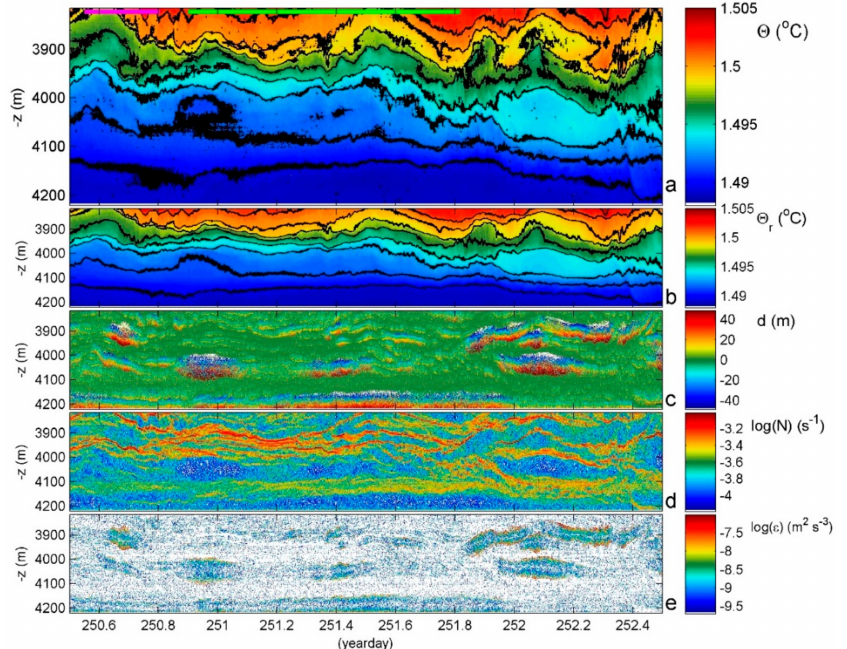
Figure 4. Two day—400 m time-depth T-sensor series example for a near-equatorial South-Pacific DRISCOL area (the local water depth is at the level of the horizontal axis). ( a ) Observed conservative temperature with missing sensors interpolated (see text) and black contours every 2 mK. The green and purple horizontal bars indicate the maximum and mean buoyancy periods, respectively. ( b ) Data from ( a ) reordered to stable profiles. ( c ) Displacements between data from ( a , b ). ( d ) Buoyancy frequency computed from data in ( b ). ( e ) Dissipation rate computed from data in ( c , d